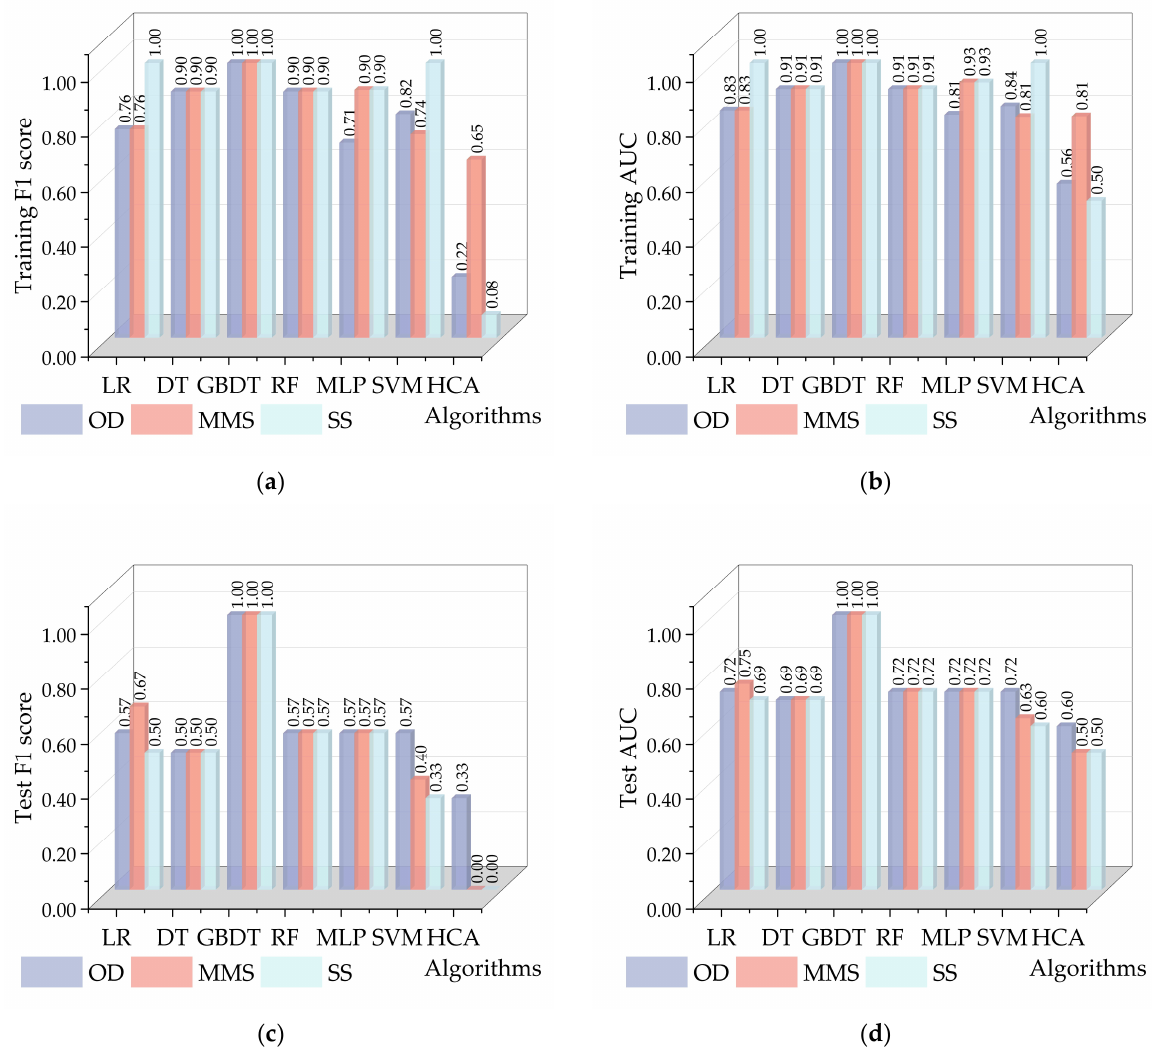
Figure 2. Performance evaluation of all machine learning models. ( a ) F1 score and ( b ) AUC of the model on the training set ; ( c ) F1 score and ( d ) AUC of the model on the test set.